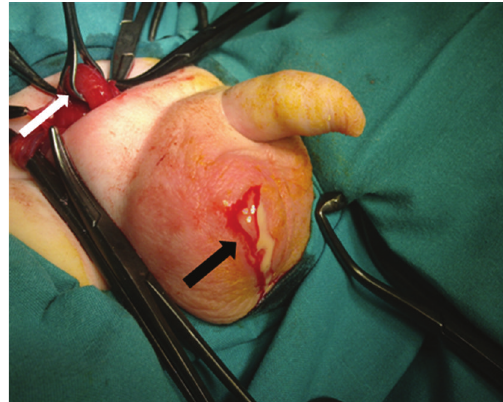
Figure 2: Purulent fluid of hemiscrotum—black arrow and appendix in hernia sac—white arrow.